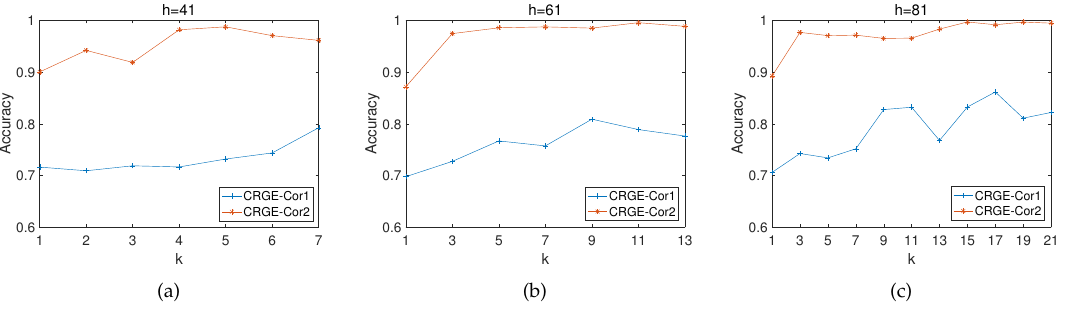
Figure 5. Classification accuracies comparison of CRGE-Cor1 and CRGE-Cor2 with different sizes of the local patch h and numbers of neighbouring samples k on the subset of the Flevoland data set. ( a ) h = 41 with k ranging from 1 to 7, ( b ) h = 61 with k ranging from 1 to 13 and ( c ) h = 81 with k ranging from 1 to